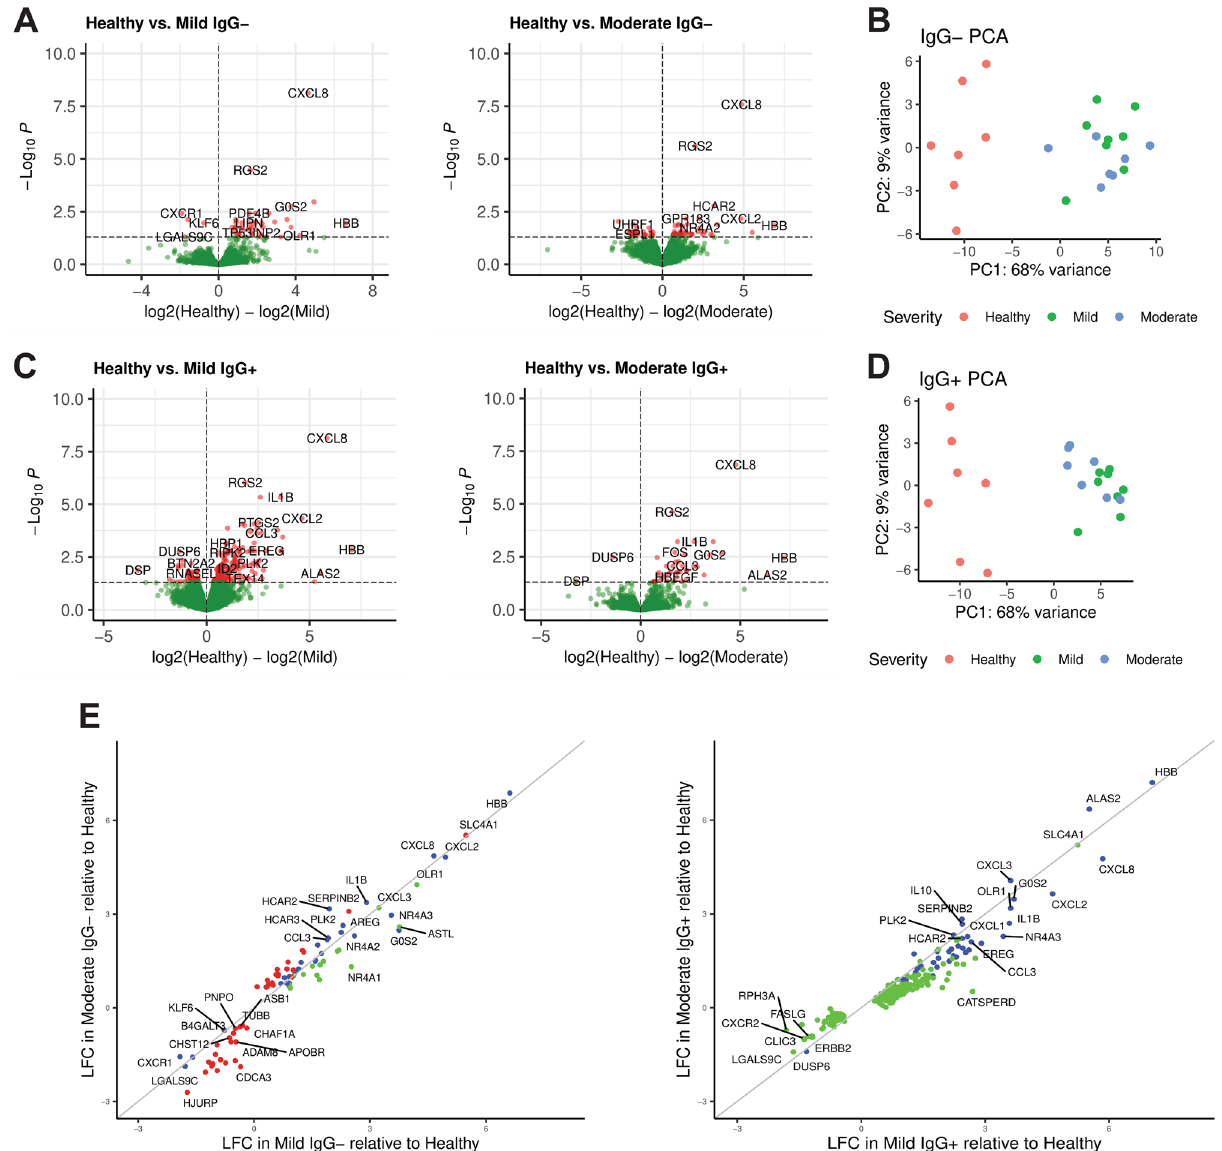
Figure 1. Differential gene expression in peripheral blood mononuclear cells (PBMCs) distinguishes COVID- 19 symptom severity. ( A ) Volcano plot depictions of differential gene expression from comparisons of healthy controls to IgG− subjects with mild symptoms (left), and healthy controls to IgG− subjects with moderate symptoms (right). Differential expression in genes with p ≤ 0.05 are plotted in red. ( B ) Principal component analysis (PCA) using differentially expressed genes identified in IgG− subjects with mild symptoms (green) and moderate subjects (blue) show distinct separation from healthy controls (red). ( C ) Volcano plot depictions of differential gene expression from comparisons of healthy controls to IgG+ subjects with mild symptoms (left), and healthy controls to IgG+ subjects with moderate symptoms (right). Genes with p ≤ 0.05 are plotted in red. ( D ) PCA using differentially expressed genes identified in IgG+ subjects with mild symptoms (green) and moderate subjects (blue) show distinct separation from healthy controls (red). ( E ) Log fold change (LFC) in differentially expressed genes in IgG− subjects with mild symptoms as a function of IgG− subjects with moderate symptoms (left) and likewise in IgG+ subjects (right). Genes differentially expressed in mild compared to healthy are green, moderate compared to healthy are red and genes differentially expressed in mild or moderate compared to healthy controls are